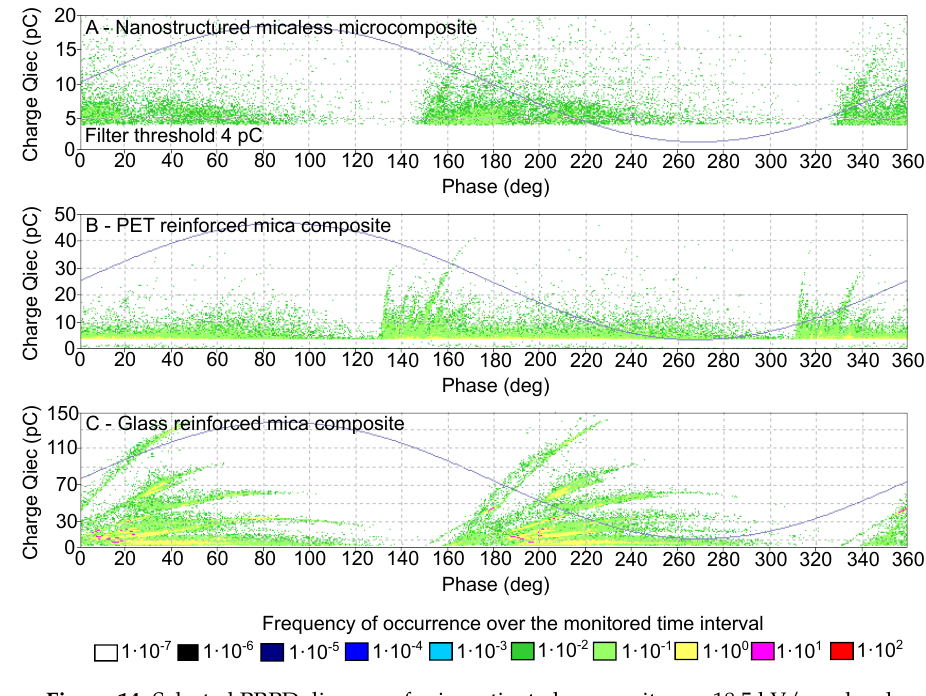
Figure 14. Selected PRPD diagrams for investigated composites on 18.5 kV/mm